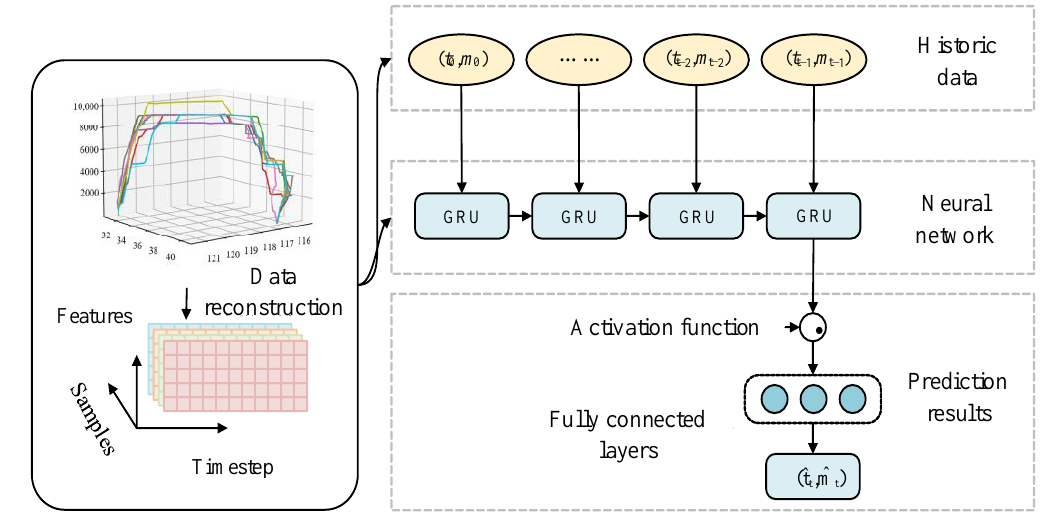
Figure 1. The GRU architecture for aircraft trajectory prediction.